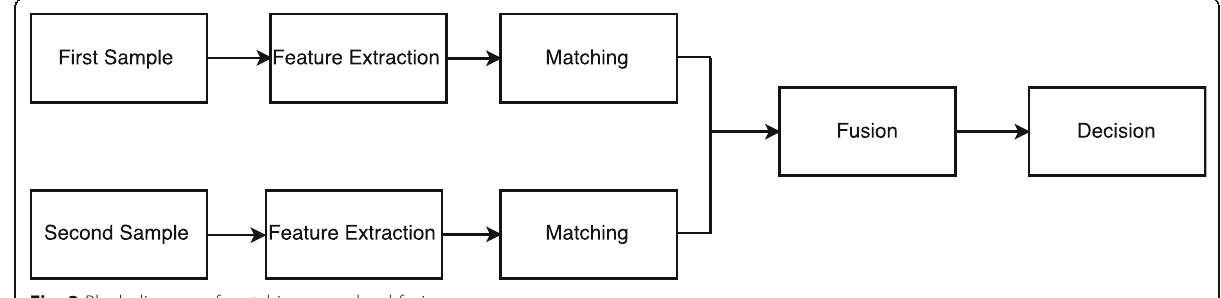
Fig. 3 Block diagram of matching score-level